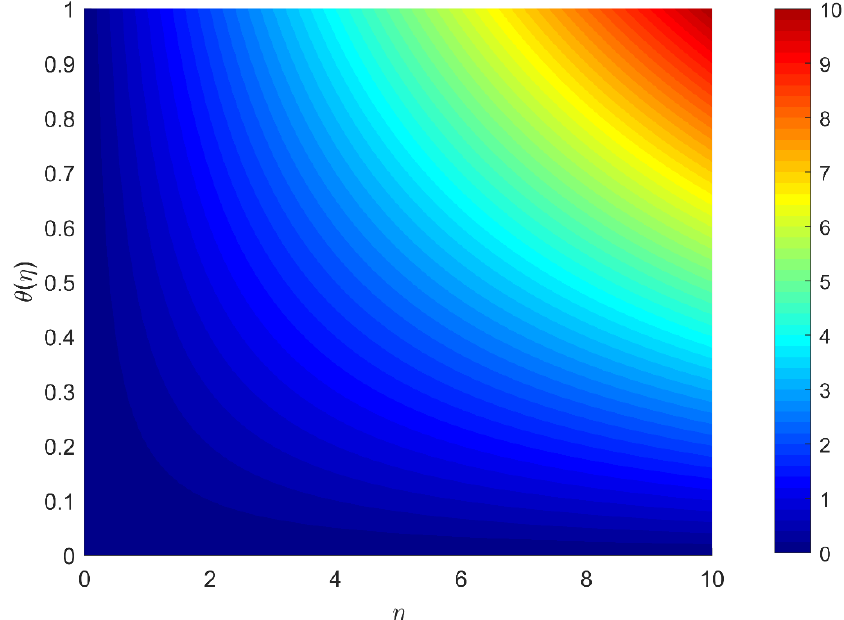
Figure 6. Isotherm plot under the study parameters.